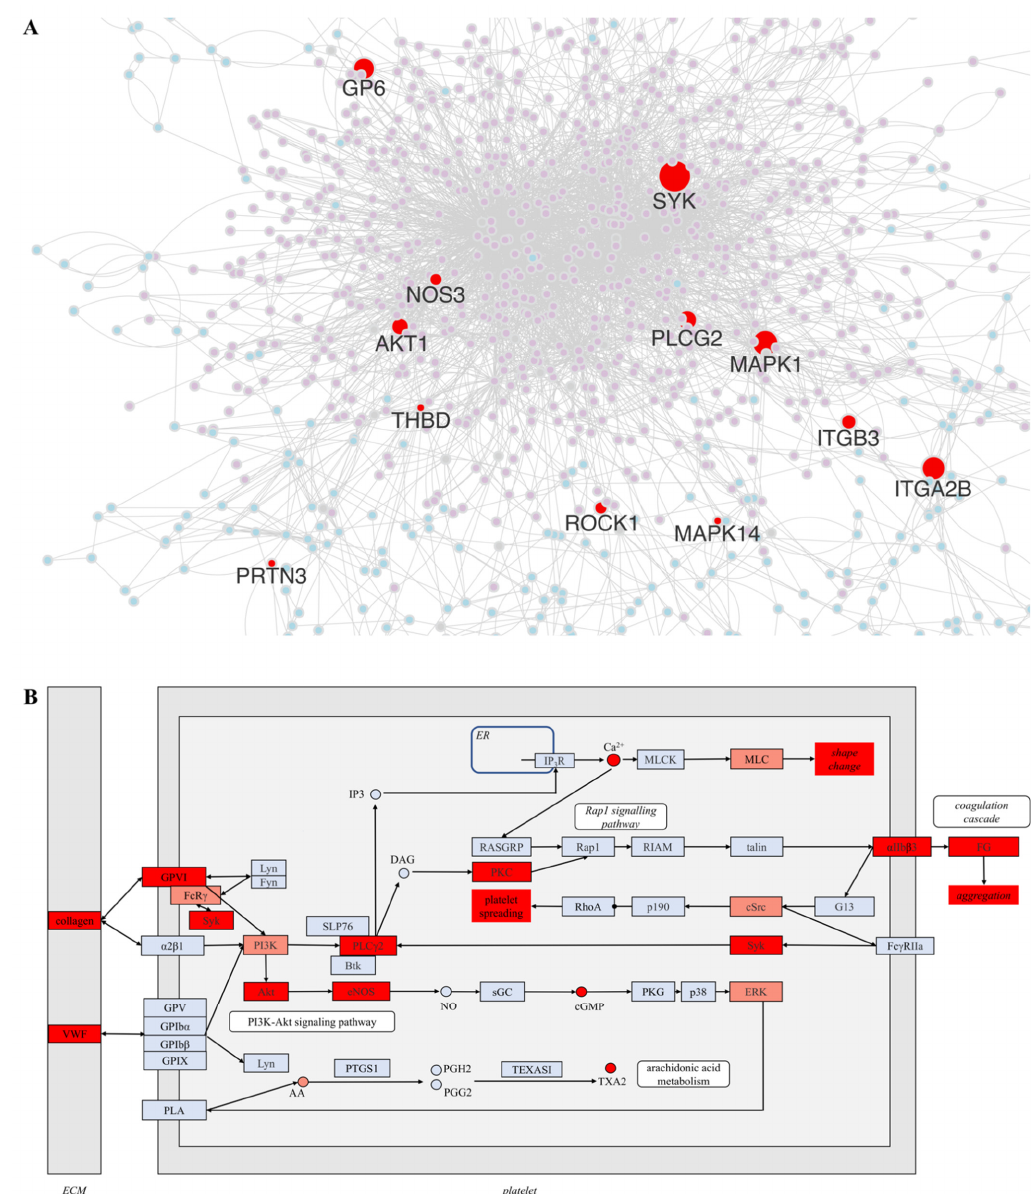
Figure 4. Heme-affected membrane-associated and intracellular proteins in clotting processes. ( A ) The overlay of HemeThrombKG (light purple nodes) and the clotting pathways extracted from da- tabases (light blue nodes) reveals several membrane-associated (i.e., receptors and integrins) and intracellular proteins as common nodes (red). ( B ) HemeKG 2.0 shares distinct proteins with the platelet activation signaling pathways (HSA04611, KEGG [28]). The pathways with the highest level of overlap are depicted, with the common proteins highlighted in red. Relevant small molecules, i.e., IP3, DAG, PGH2, PGG2, TXA2, NO, and cGMP, Ca 2+ ions, as well as essential platelet activation